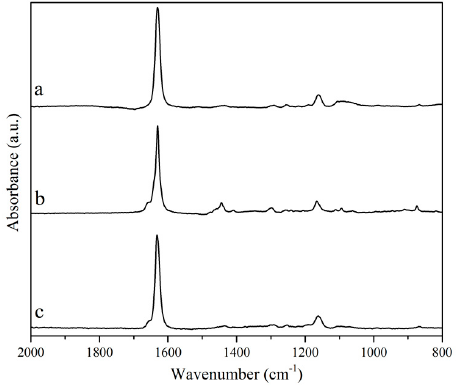
Figure 3. Raman spectra of ( a ) tung oil, ( b ) isolated α -eleostearic acid, and ( c ) tung oil methyl ester.